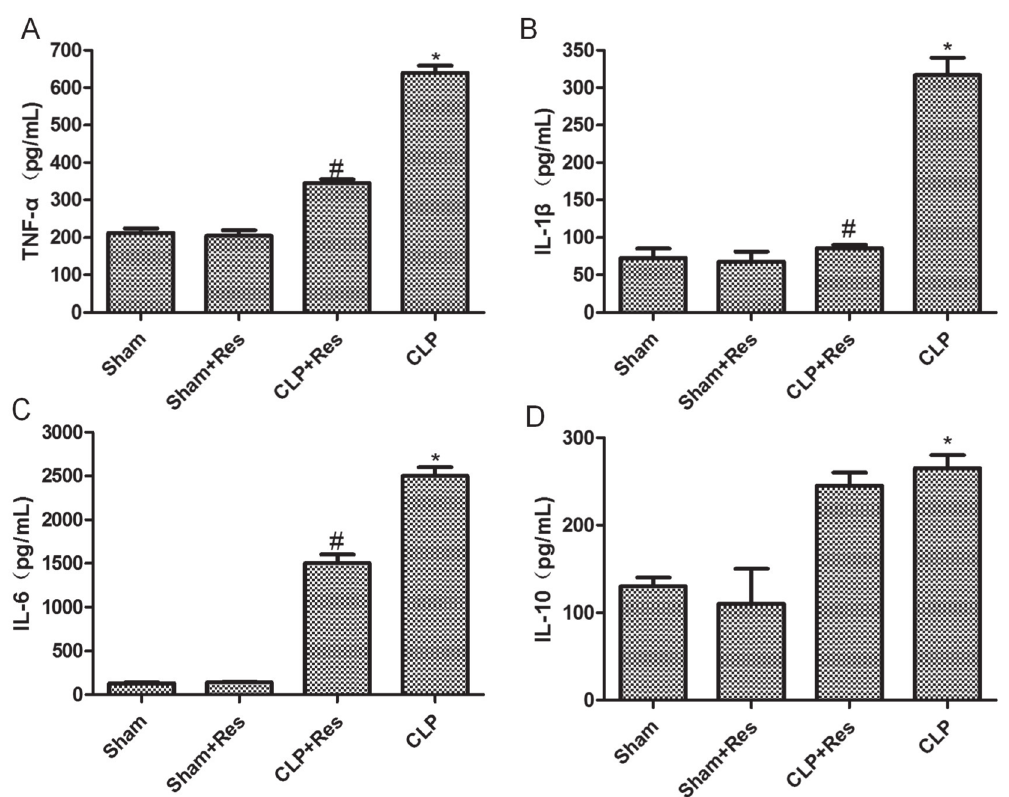
Fig. 6. Effects of resveratrol on serum (A) TNF-α, (B) IL-1β, (C) IL-6 and (D) IL-10 levels in septic rats 6 h after surgery. *Compared with Sham group, P <0.05; #compared with CLP group, P <0.05.